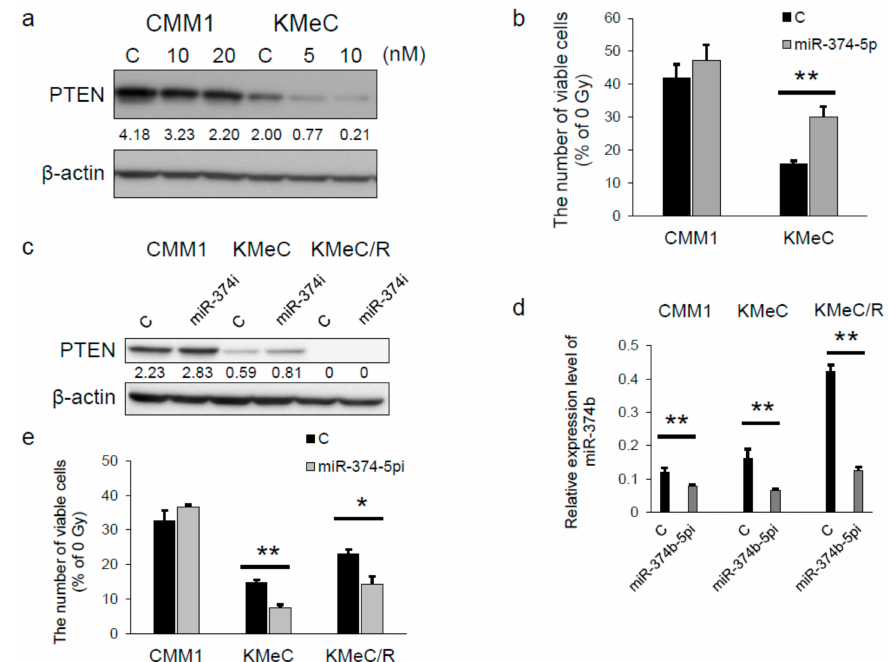
Figure 4. Ectopic expression of miR-374b-5p decreased the expression level of PTEN and conferred radioresistance on KMeC cells. ( a ) Western blot analysis of PTEN in the CMM1 and KMeC cells transfected with miR-374b-5p at the indicated doses. The assay was performed 48 h after the transfection. The values between the panel of PTEN and β -actin were the intensities of PTEN normalized to that of β -actin. ( b ) Cell count analysis of the cells transfected with miR-374b-5p (CMM1; 20 nM and KMeC; 10 nM) after 8 Gy of irradiation. The cell count was performed 72 h after the irradiation. Western blot analysis of PTEN ( c ) and the expression level of miR-374b ( d ) in the cells transfected with the negative control or 20 nM miR-374b-5pi. The assays were performed 72 h after the transfection. The values between the panel of PTEN and β -actin were the intensities of PTEN normalized to that of β -actin. ( e ) Cell count analysis of the cells transfected with miR-374b-5pi at a dose of 20 nM after 8 Gy of irradiation. The cell count was performed 72 h after the irradiation. The data are shown as a % of the number of the cells without irradiation. * p < 0.05 and ** p < 0.01, for di ff erences between the samples indicated by the horizontal lines. Data are expressed as the mean + SD ( n =